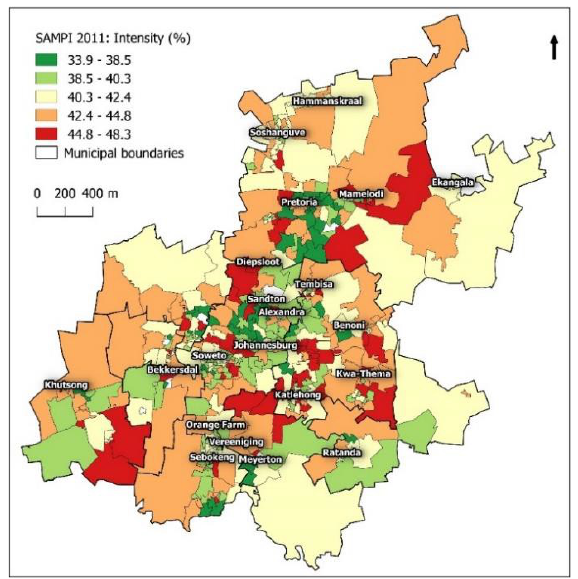
Figure 4. Intensity of poverty (%) in 2001